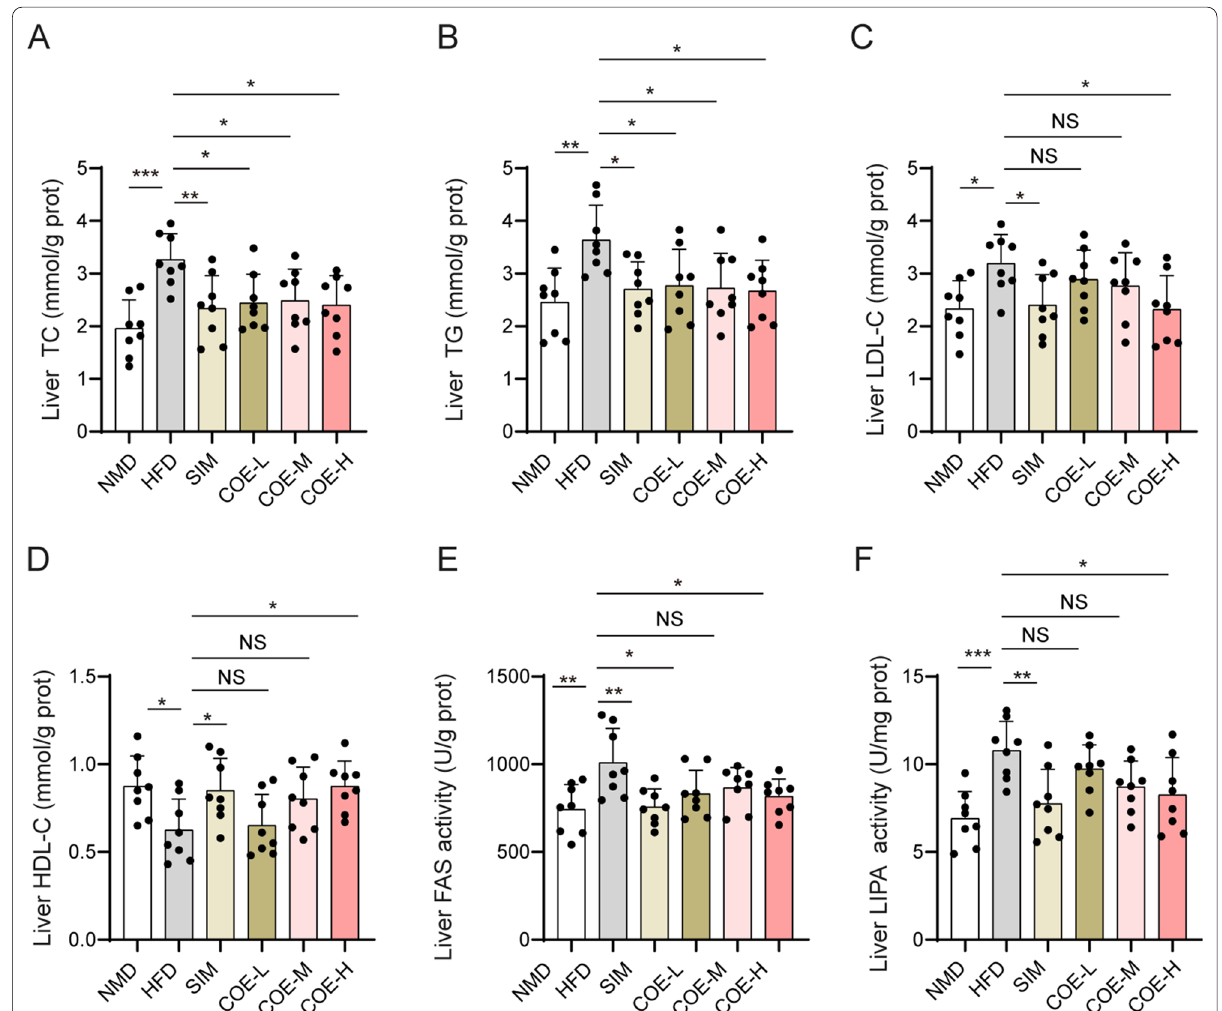
Fig. 3 Effects of COE on lipid levels and lipase activities in liver tissues. TC ( A ), TG ( B ), LDL-C ( C ), HDL-C ( D ), FAS ( E ), and LIPA ( F ) levels in liver tissues of hyperlipidemic rats were measured after COE or SIM treatment. n